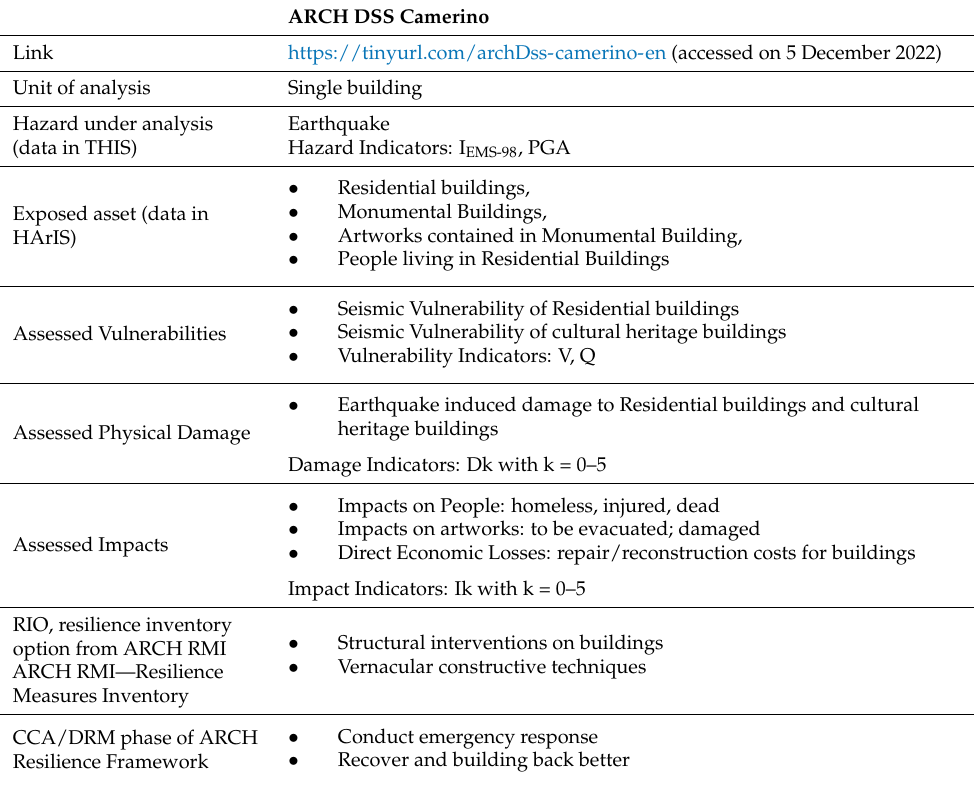
Table 4. Requirements for Camerino ARCH DSS dashboard .